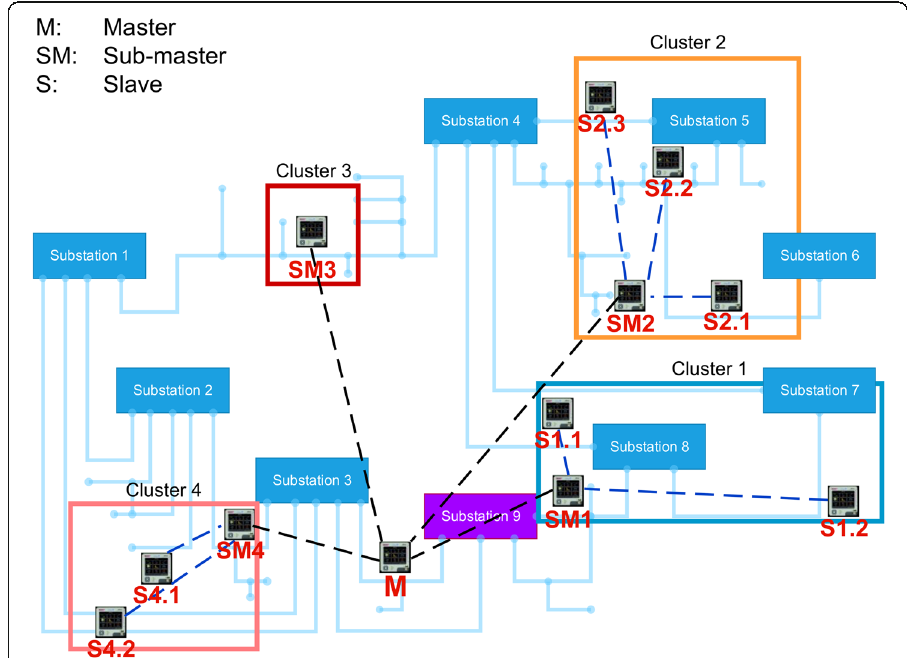
Fig. 3 Example LV/MV grid with topological distributed